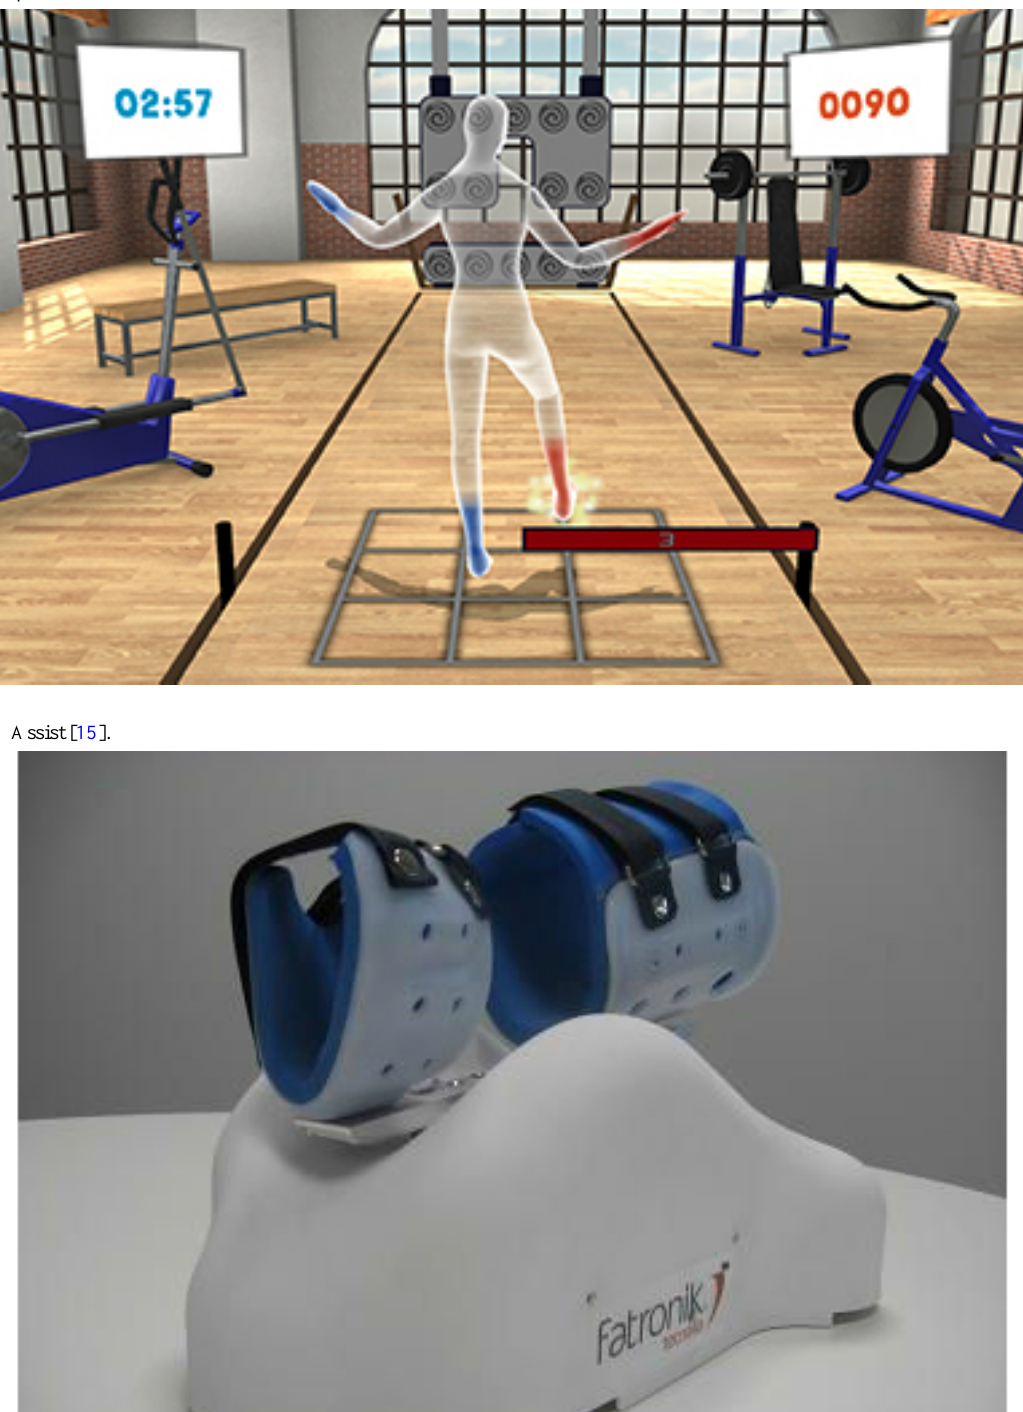
Figure 1. Example of exercises done in Virtual Rehab [11].